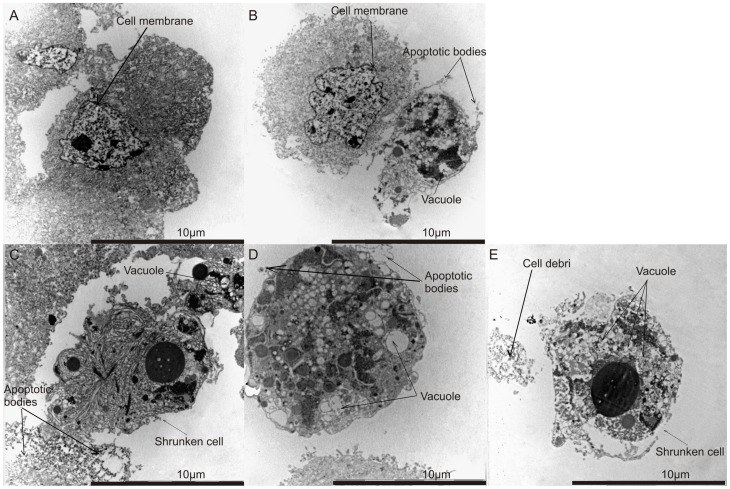
Morphology investigation using transmission electron microscopy.TEM revealed vehicle-treated cells displaying no signs of distress (A). Cells treated with 2-methoxyestradiol-bis-sulphamate (B), ESE-16 (C) and ESE-15-one (D) demonstrated the occurrence of apoptotic bodies and vacuole formation. Cells treated with EMBS (E) displayed an increase in the number of vacuoles.